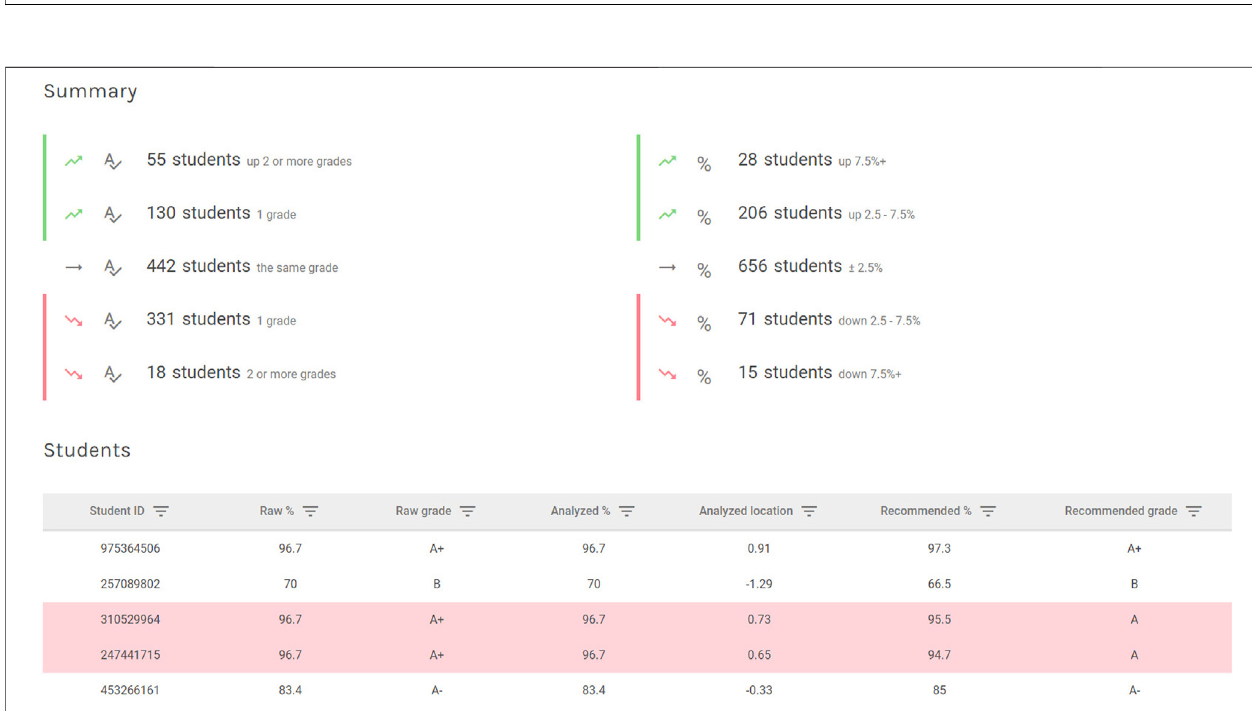
FIGURE 5 | Standard setting display transformed grade display.